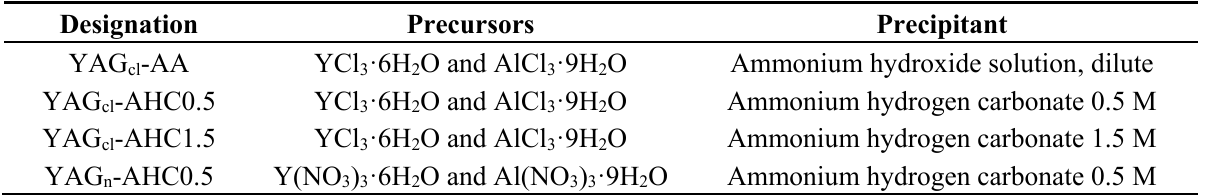
Table 1. Materials designation as a functional of the co-precipitation experimental conditions.